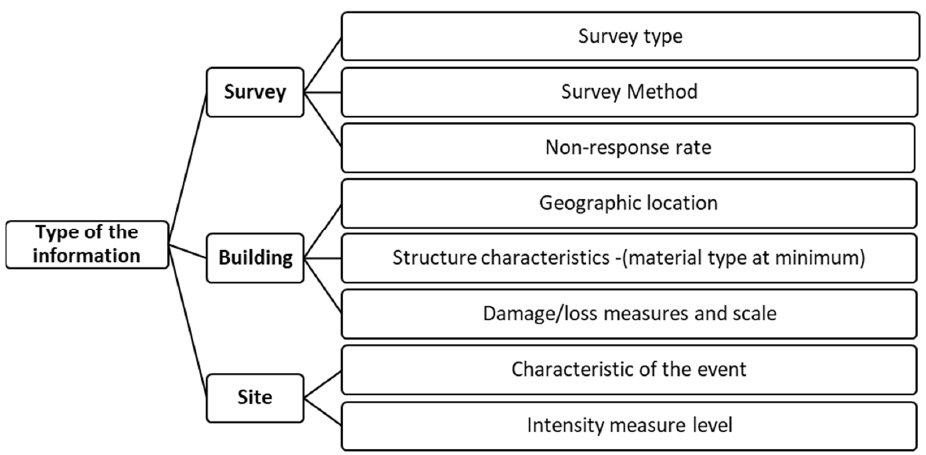
Figure 4. The minimum number of information required for an empirical database